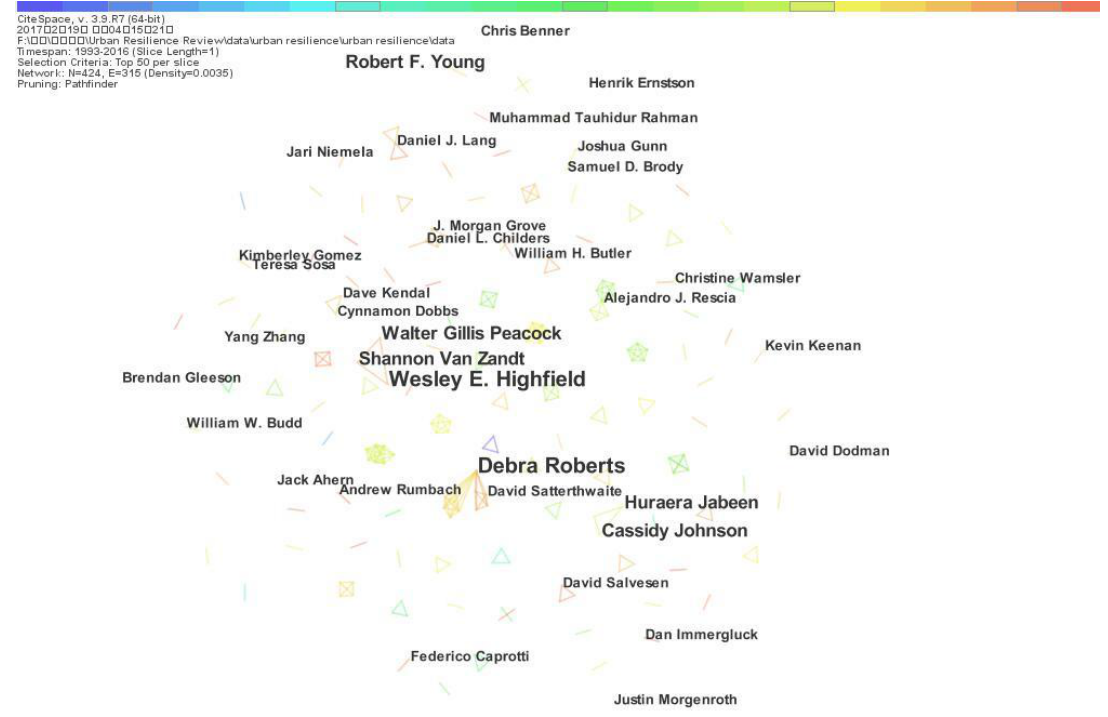
Figure 3. Co-authorship network.